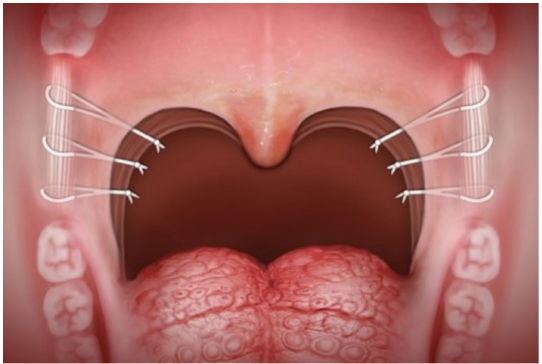
Figure 3. Raphe-based omni-suspension of the soft palate.